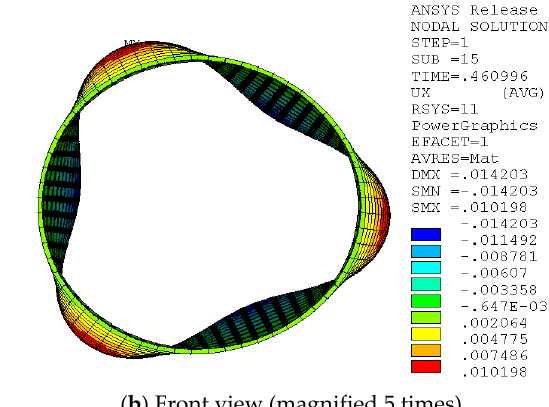
Figure 11. Radial displacement contour map at the upper critical point of the post-buckling path for the model of the T-type stiffened cylinders with the SS3 boundary condition when the material is AL and ξ = 0.05.